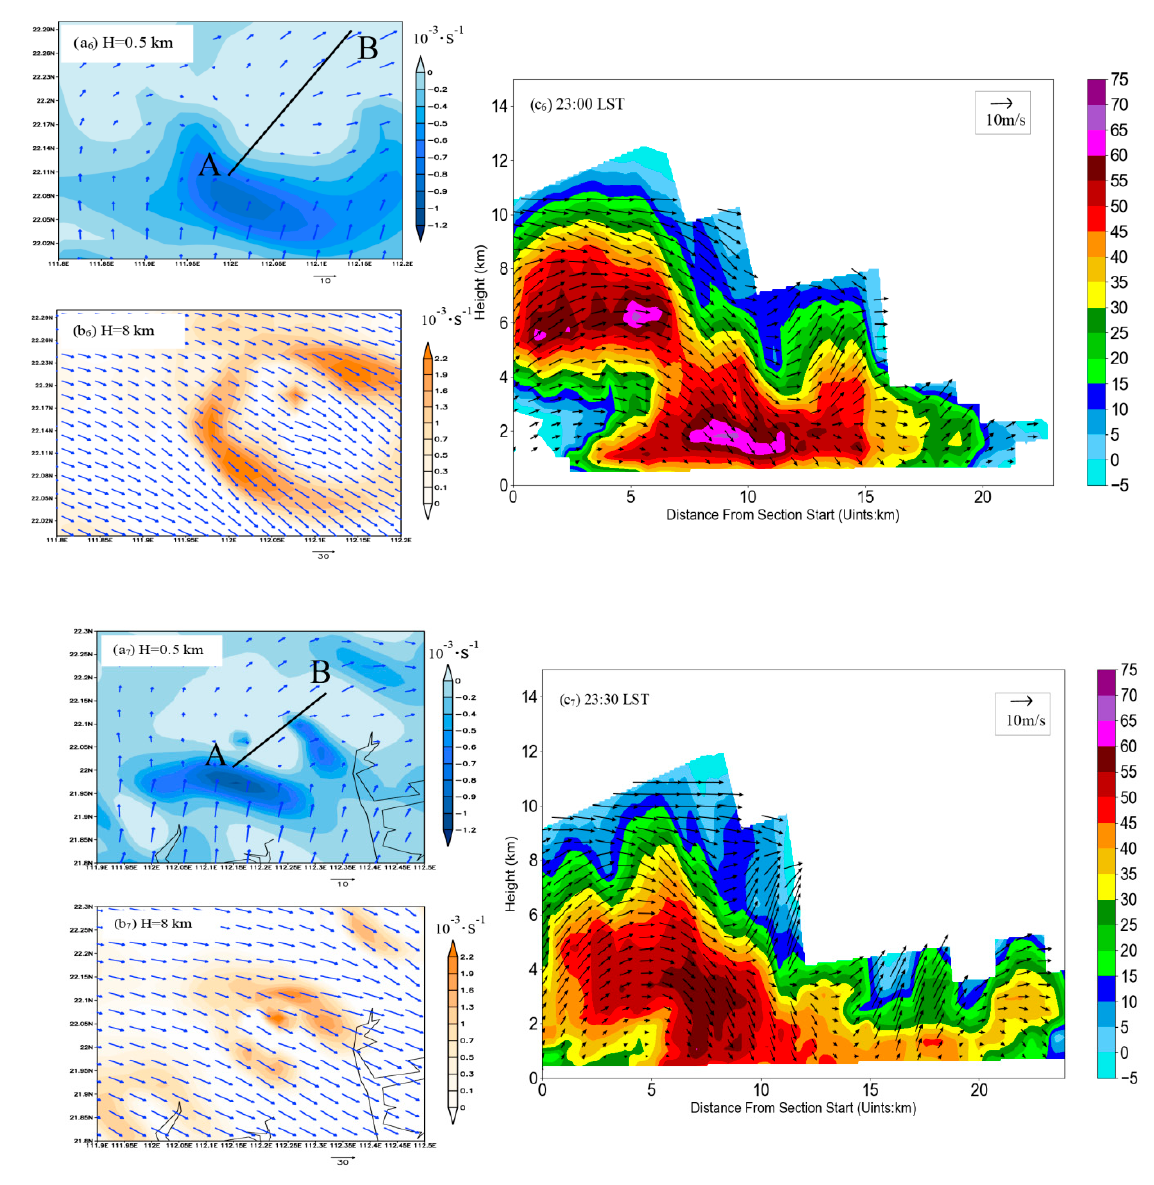
Figure 11. A and B represent horizontal winds (arrows) and divergence (shading) of VDRAS reanaly- sis. ( a1 – a7 ) At 0.5 km AGL. ( b1 – b7 ) At 8 km AGL. ( c1 – c7 ) Vertical cross-sections of winds (arrows) and ZH (shade) along the black lines are given in ( a1 – a7 ). The vertical velocities are amplified 10 times for visualization.